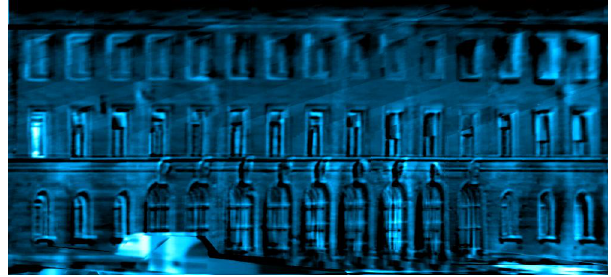
Figure 8. Temperature differences of two textures from different image